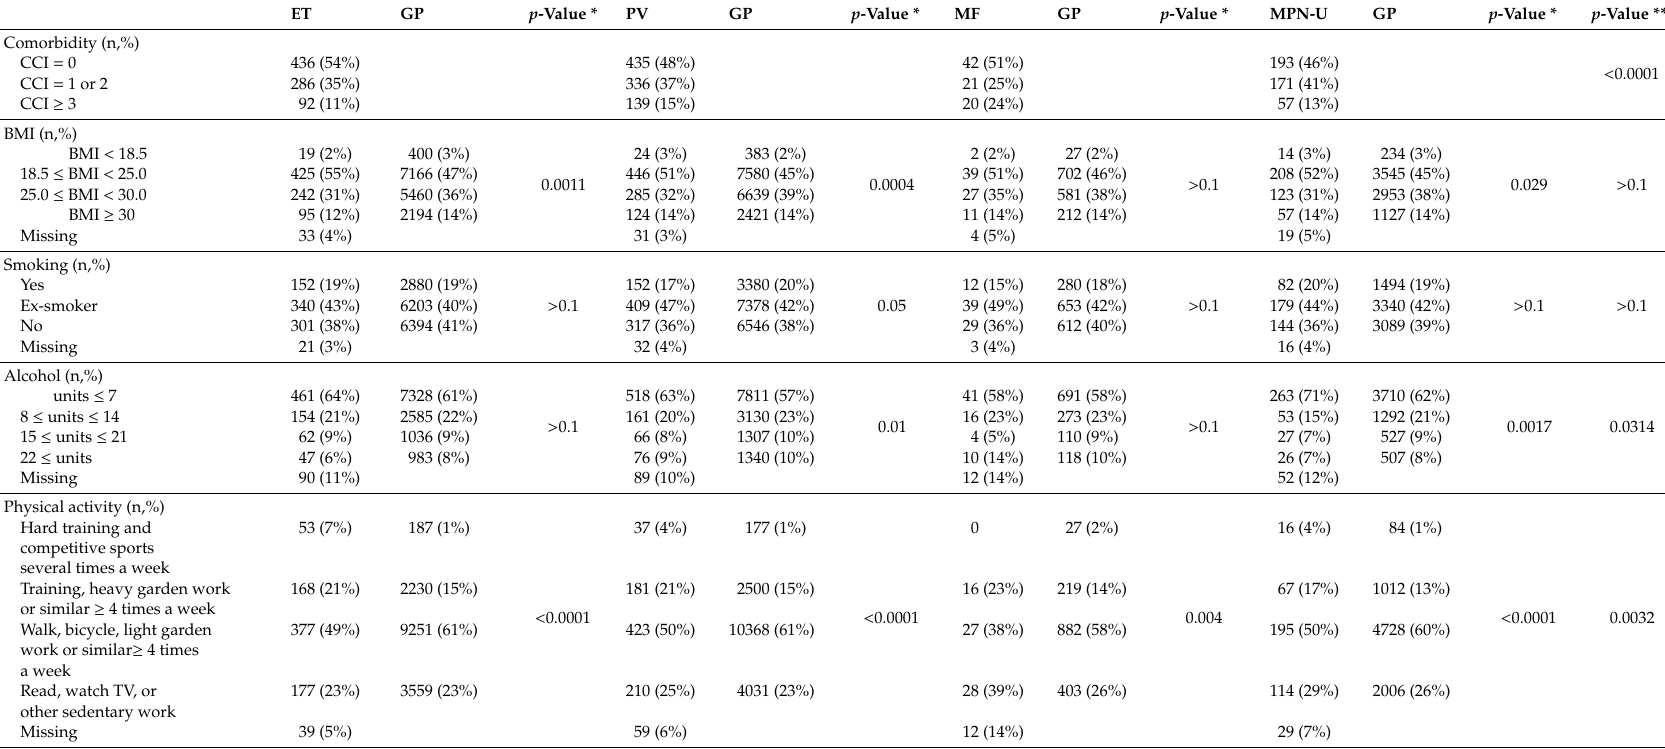
Table 5. Comorbidity and lifestyle. Di ff erences in lifestyle between the MPN subgroups and the general population. Di ff erences in comorbidity and lifestyle between participants with di ff erent MPN